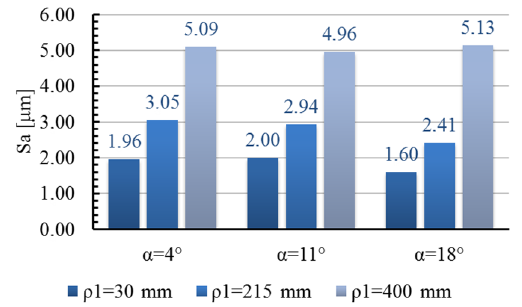
Figure 20. Statement of the measurement results of the parameter Sa of the convex surface of the turbine blade.